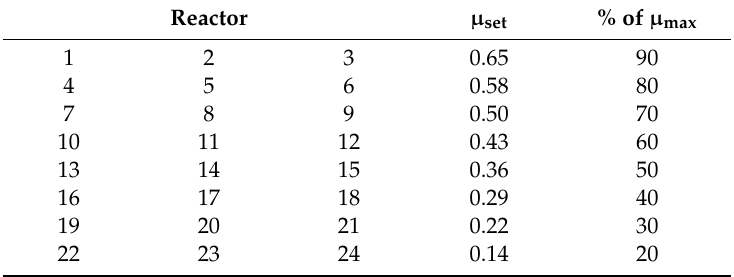
Table 1. Summary of applied feed rates for cultivation of E. coli BW25113 (pAG032). The listing of the reactors in columns and rows represents the reactor allocation at the two liquid handling stations